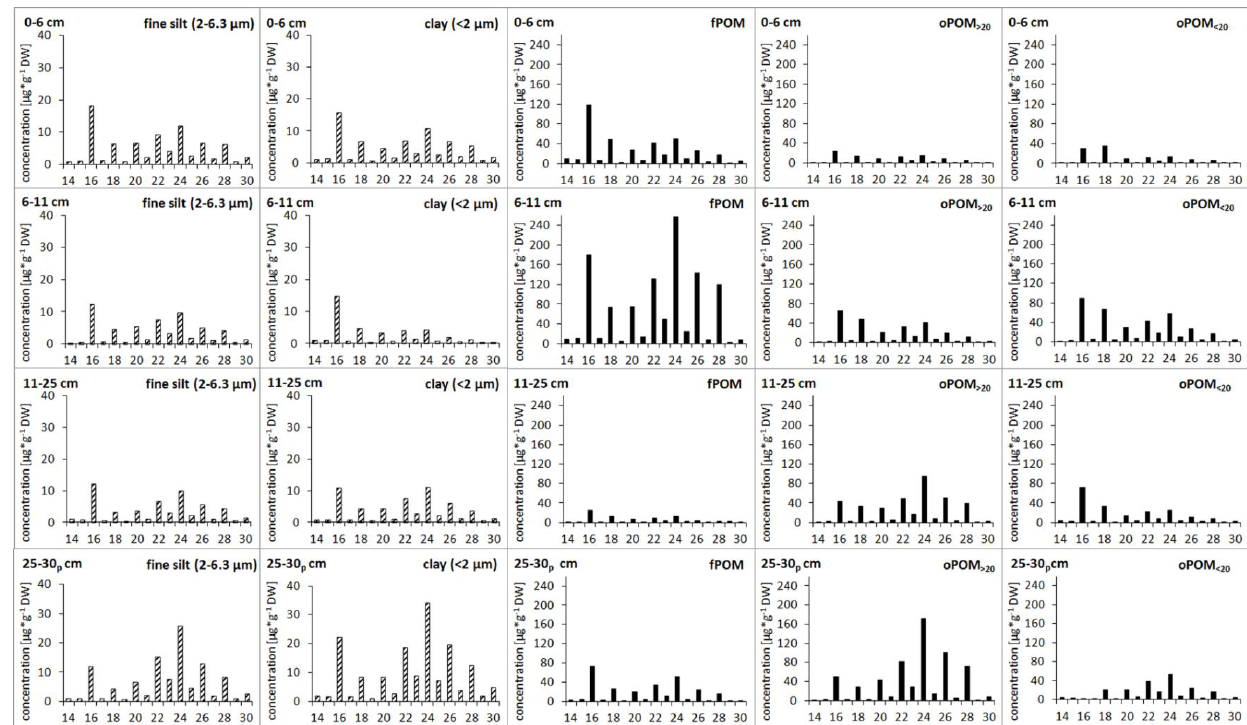
Figure 4. Distribution of n -fatty acids in fine silt and clay (striped) and in density fractions (black) from different depths intervals. Only even n -fatty acids are labelled on the x-axis; note different scaling of y-axis. 3